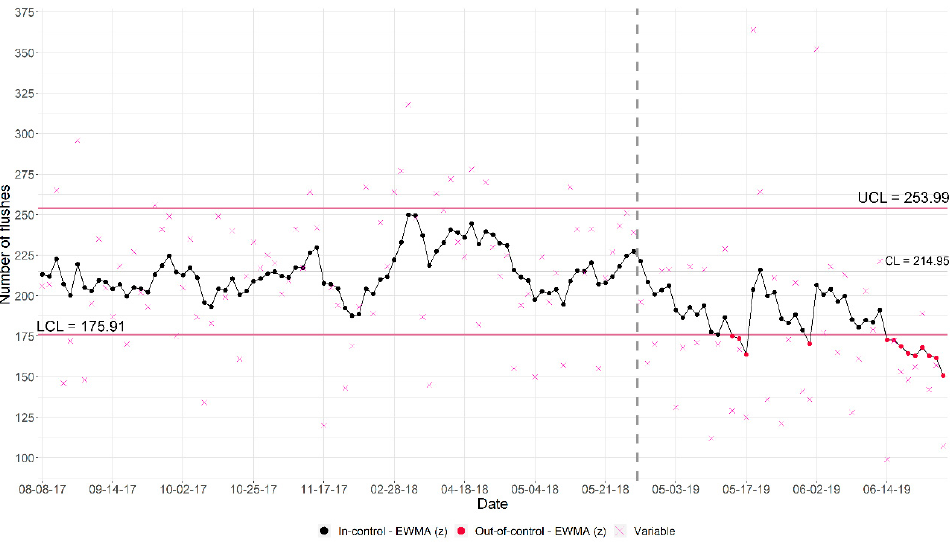
Figure 4. EWMA Control Chart—Total number of flushes per day.